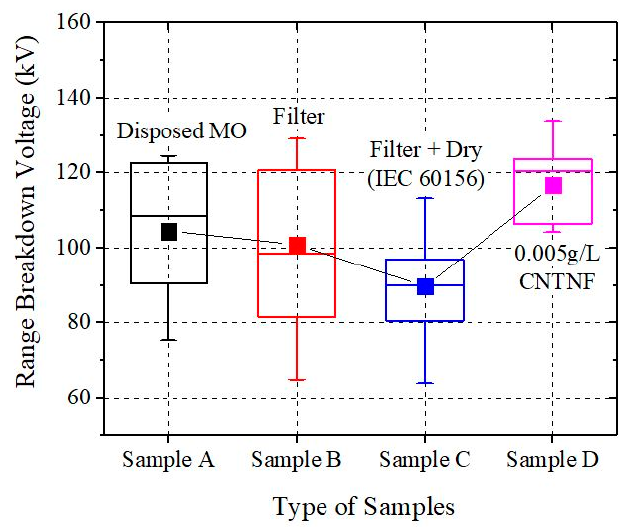
Figure 10. Box chart of lightning impulse measurements for all types of oil samples. Table 5. Descriptive statistic of fifteen lightning impulse breakdown voltages values for different oil samples.